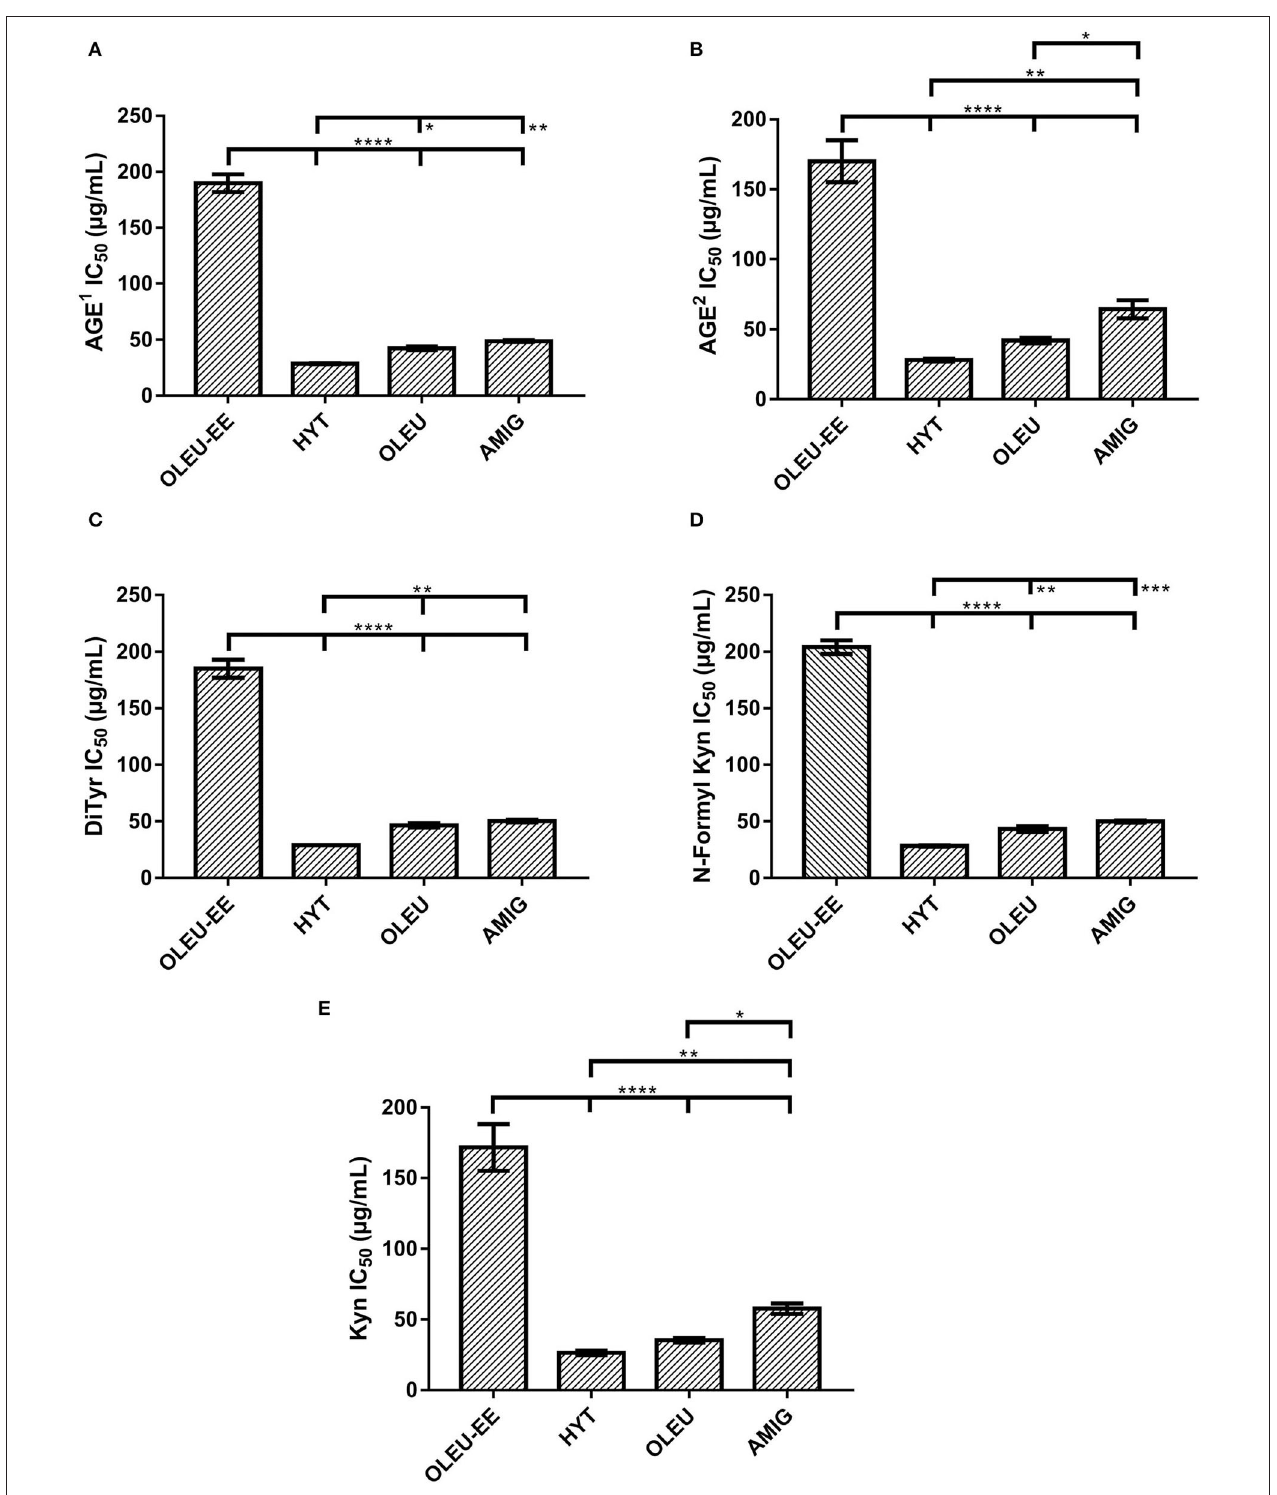
FIGURE 5 | Effect of OLEU-EE #1 obtained from olive mill leaves in the inhibition of fluorescent (A) AGEs 1 ( 1 λ EXC 325/ λ EM 440); (B) AGEs 2 ( 2 λ EXC 389/ λ EM 443); and protein oxidative modifications produced by the incubation of BSA with glucose; (C) DiTyr; (D) N-Formyl Kyn; and (E) Kyn. The means ± SD values of OLEU-EE with HYT, OLEU, and AMIG were compared by one-way ANOVA with Tukey’s test. With a confidence interval of 95% ( α = 0.05), significance is represented by brackets with one asterisk (*) identify adjusted P- values between 0.01 and 0.05, two asterisks (**) identify adjusted P- values between 0.01 and 0.001, three asterisks (***) identify adjusted P- values between 0.001 and 0.0001, and four asterisks (****) identify adjusted P- values < 0.0001.